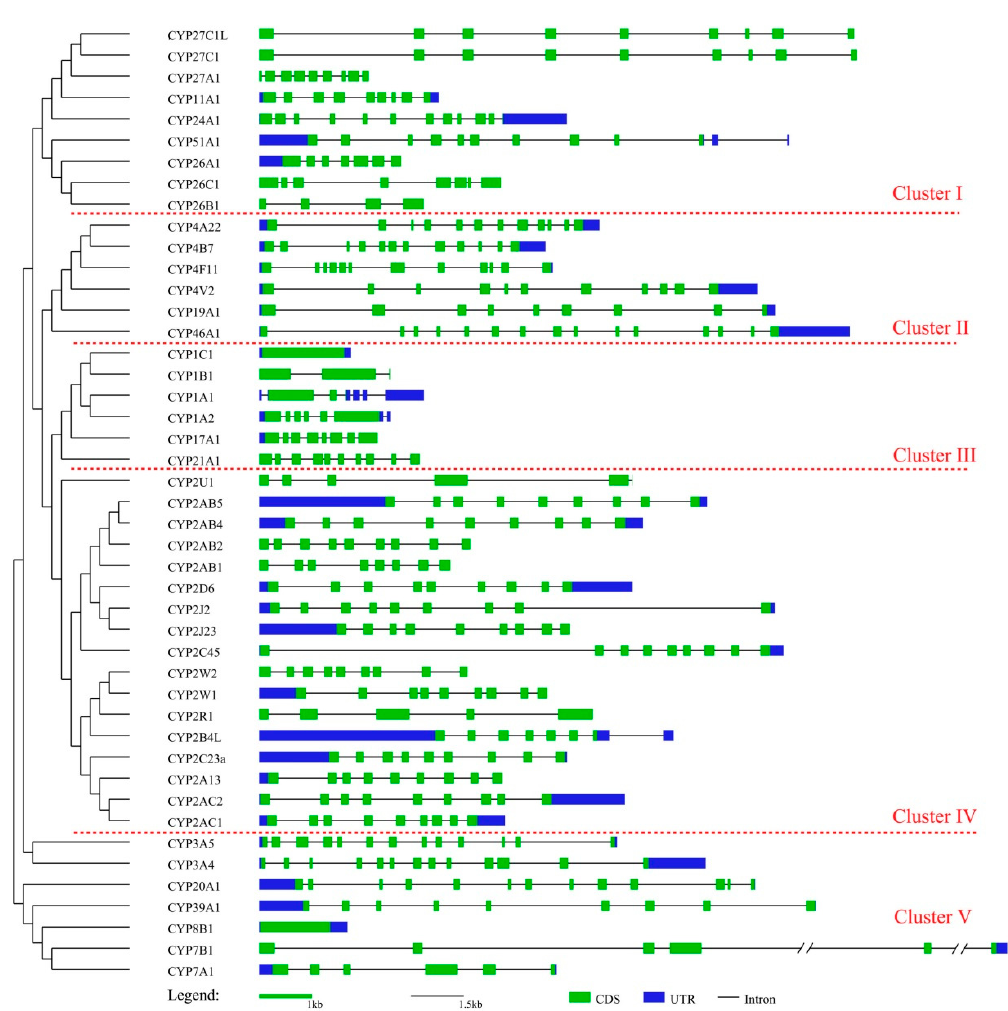
Figure 2. Chicken CYP (cCYP) phylogenetic relationships and gene structures. The phylogenetic tree was built in MEGA5 using the neighbor-joining method with 1000 bootstrap replicates. Gene structure analysis was carried out with the online tool GSDS 2.0. The length of the 5th intron in cCYP7B1 is 109,703 bp.